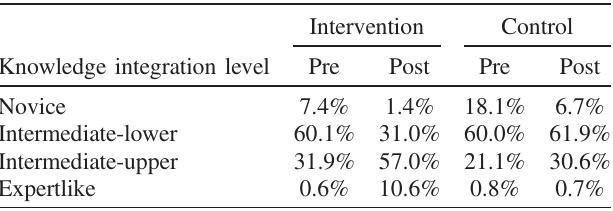
TABLE V. Percentage of students in each group at each knowledge integration level on the pre- and